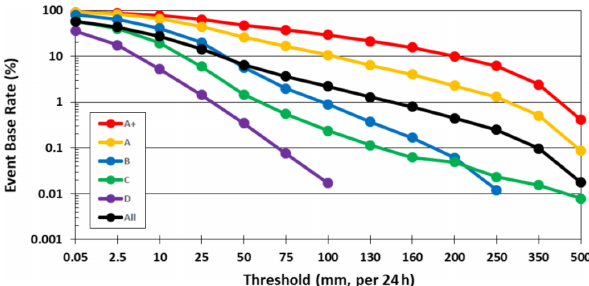
Figure 5. Observed rain area size or base rate ( O/N , %) of 24h rainfall (same for days 1–3) in logarithmic scale used to compute the scores in Fig.